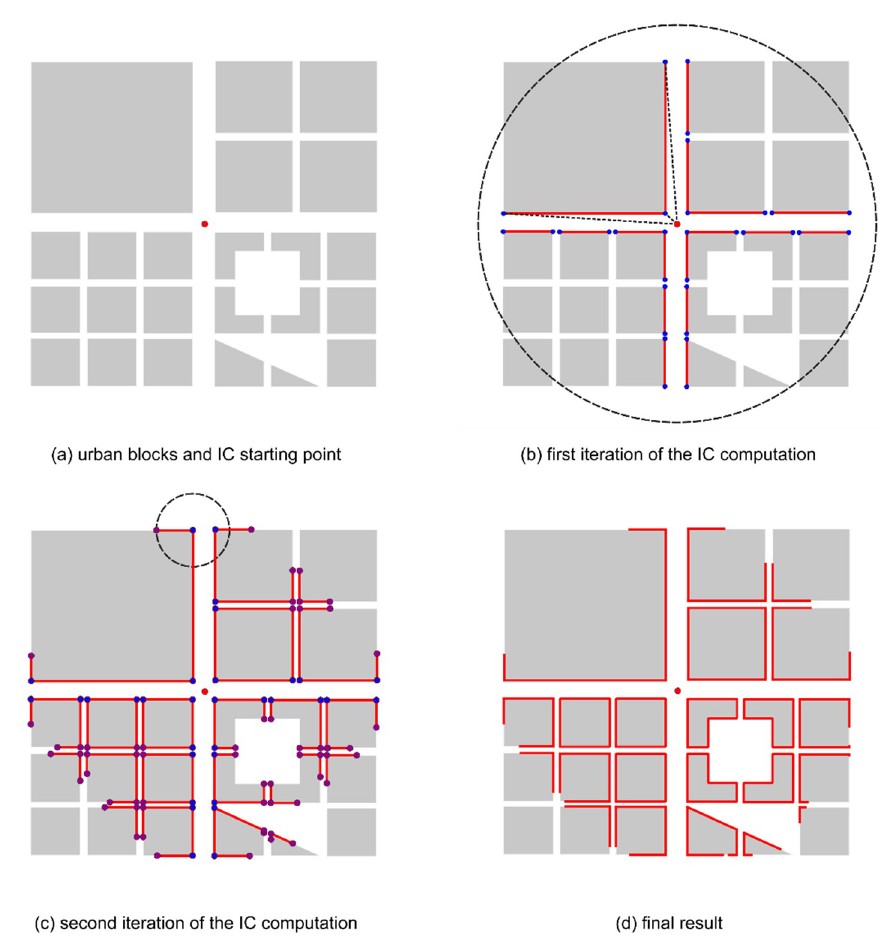
Figure 4. Example of IC computation given the urban blocks and a starting point.